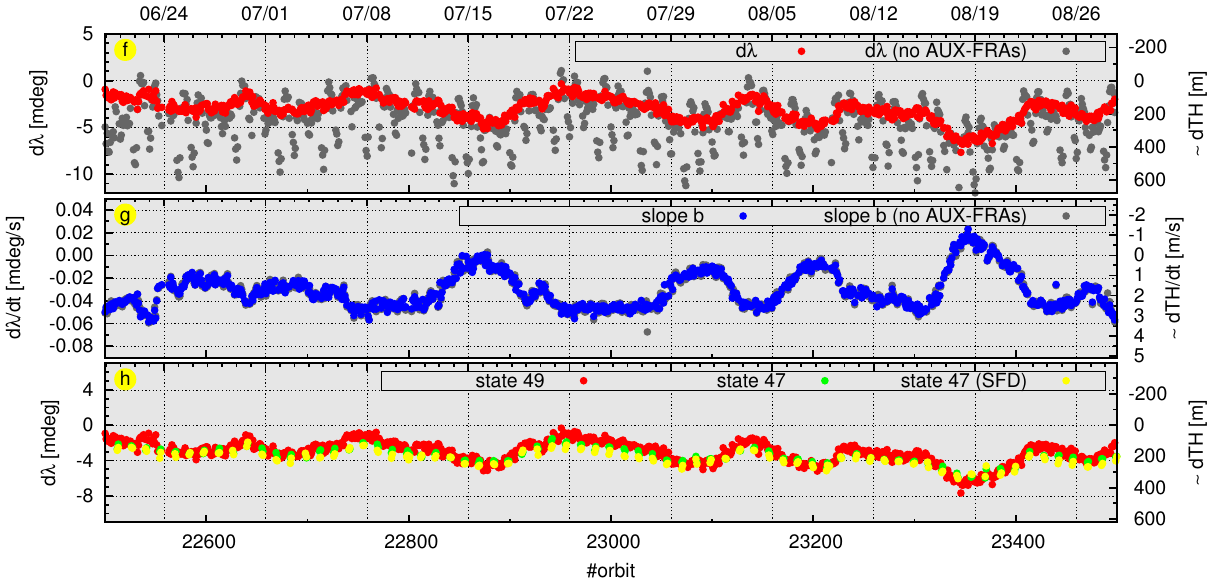
Fig. 10. Zoom of Fig. 9 (f–h) for the time range June to August 2006.